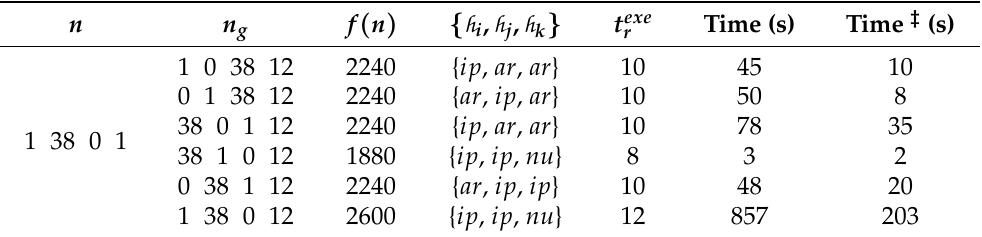
Figure 5. Example of a second rotation: ( a ) initial configuration, ( b ) configuration after a first object rotation of 180 ◦ using finger rolling, ( c ) placement of finger-3, ( d ) moving finger-1, ( e ) moving finger-2, ( f ) removing finger-1, ( g ) finger-2 on its desired place I after object rotation of 40 ◦ using finger rolling ( h ) placement of finger-1 on its desired place J, ( i ) removal of finger-3. Table 3. Comparison of cost and time computations for Ellipsoid’s second rotation. ‡ represents the time to generate path with “Tie Breaking” strategy. t exe r is the number of reconfiguration in the optimal